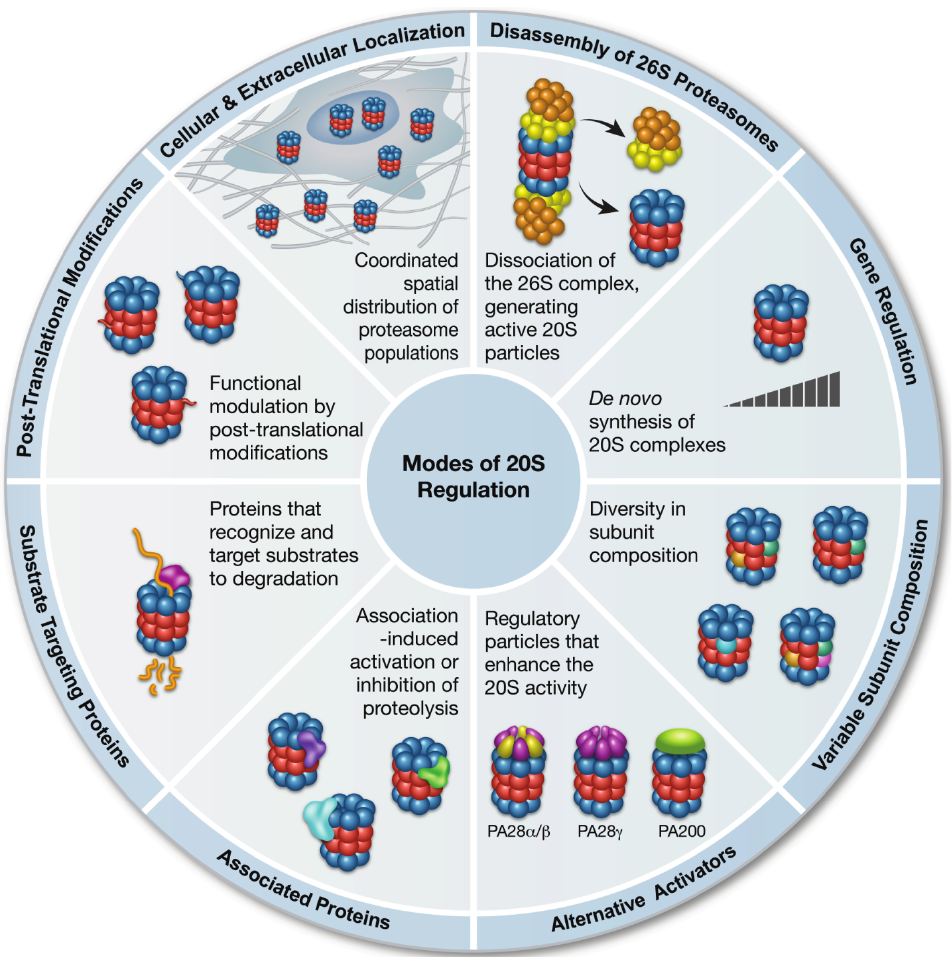
Figure 2. Specific mechanisms that regulate the function of the 20S